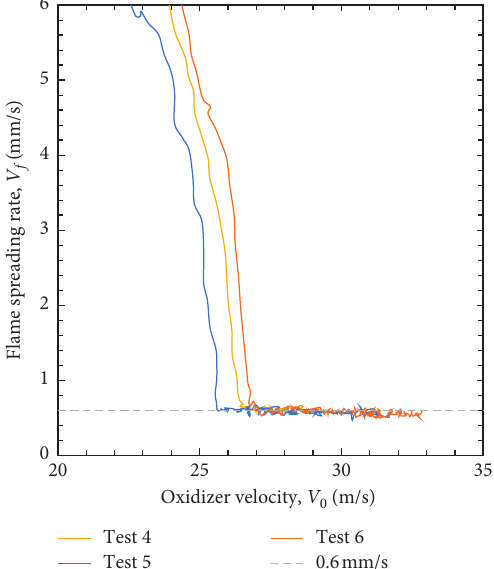
Figure 8: Flame spreading rate vs. oxidizer velocity near blow-off